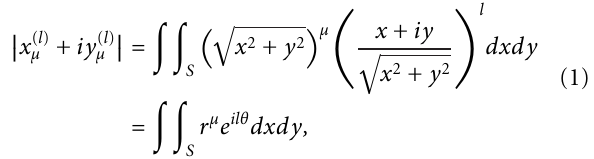
Figure 1: (a) The original bird contour before the alignment step, (b) the contour after alignment using three universal